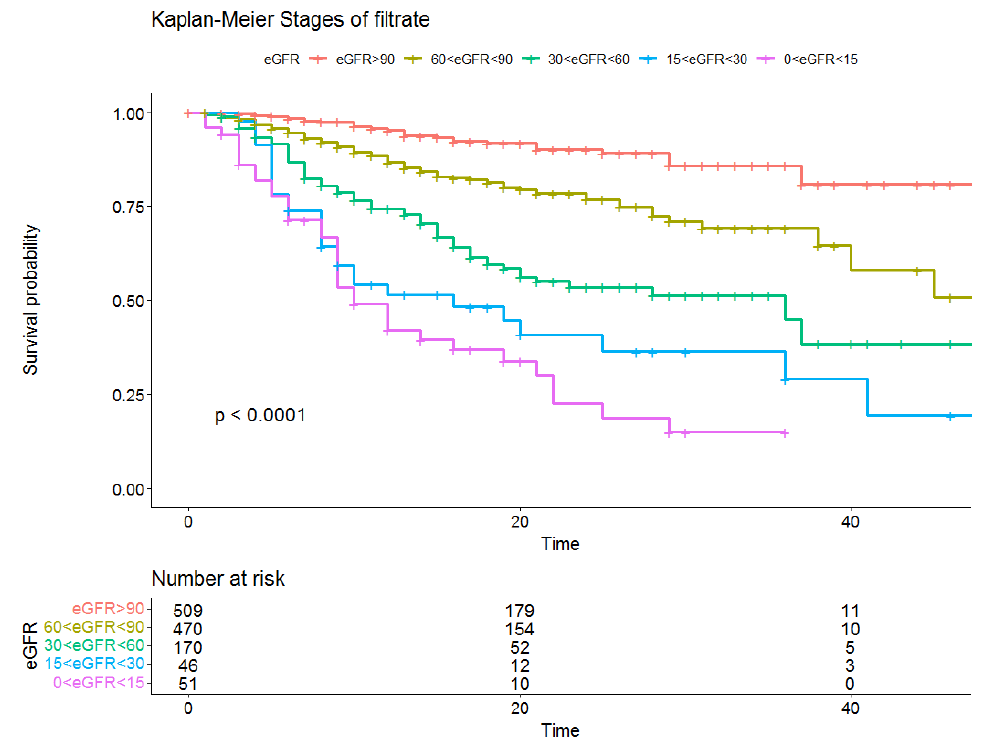
Figure 1. Kaplan–Meier survival analysis according to the stage of CKD, and the eGFR risk Figure 1. Kaplan – Meier survival analysis according to the stage of CKD, and the eGFR risk table.